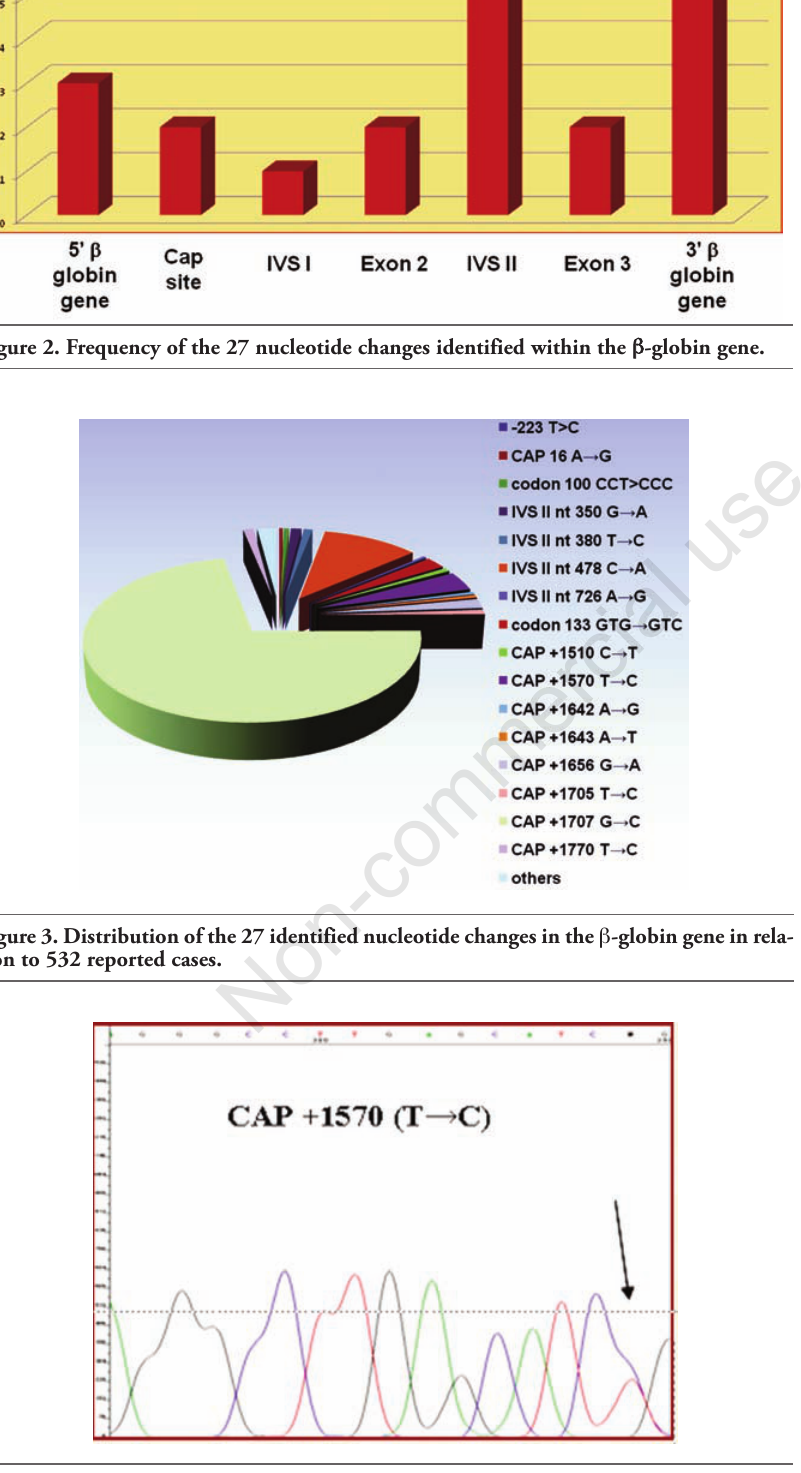
Figure 4. Partial DNA sequence of the CAP +1570 (T>C) mutation. Nucleotide substitu- tion present in heterozygous state